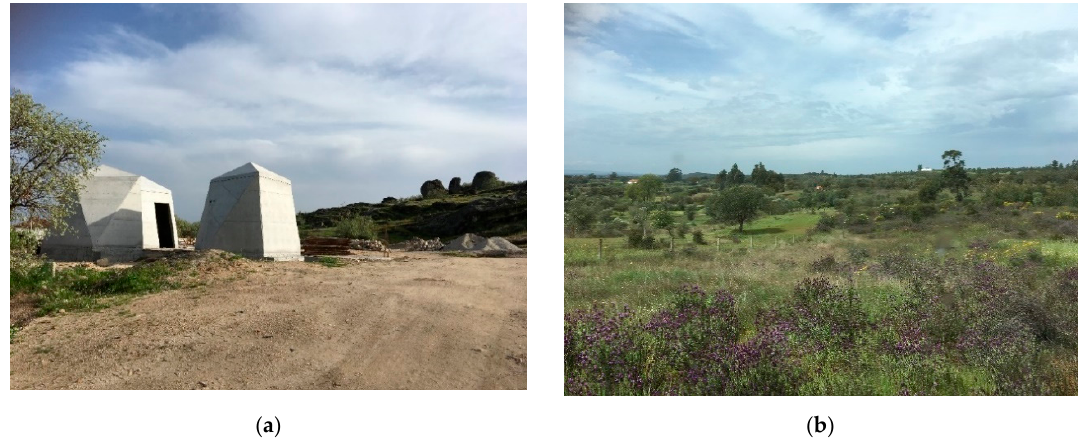
Figure 11. ( a ) The new Naturtejo UGGp information center. ( b ) Naturtejo